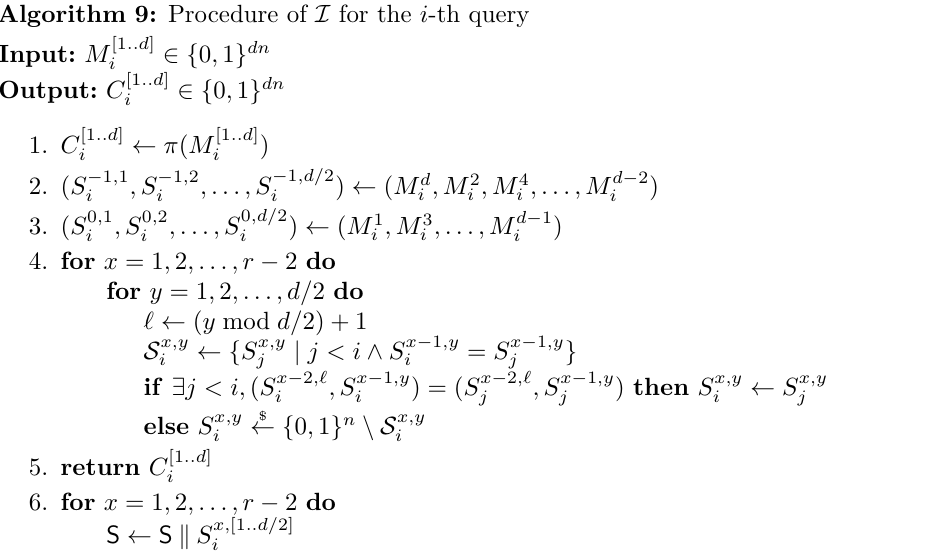
Algorithm 9: Procedure of I for the i -th query